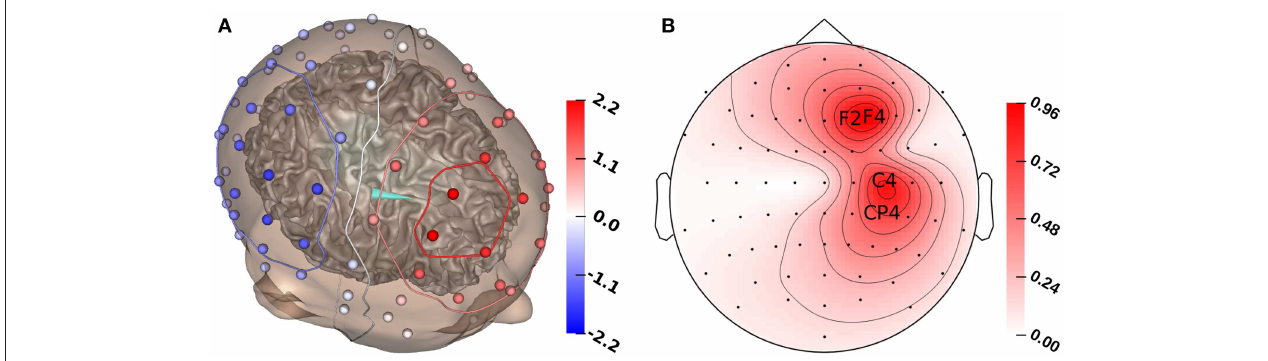
FIGURE 2 | (A) GFS source reconstruction (turquoise cone) and simulated electrode voltages for reconstructed source. (B) Standard deviation for each electrode for the multivariate distribution. The electrodes with the highest standard deviation (F2, F4, C4, CP4) are marked with their labels. All values in µ